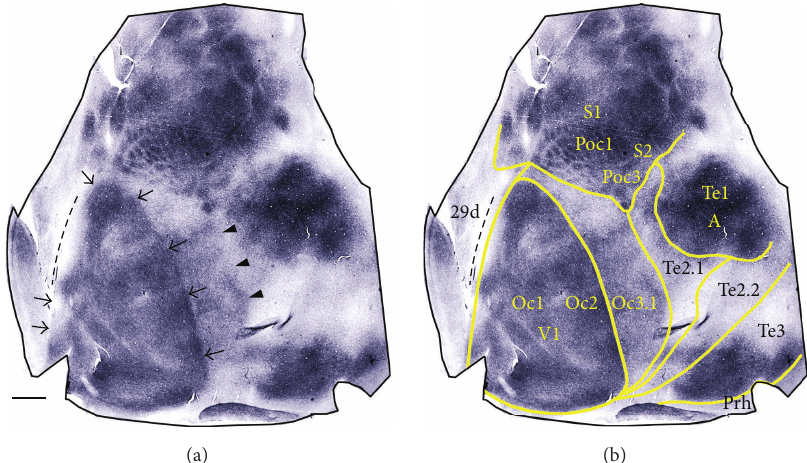
Figure 2: Myeloarchitectonic and cytoarchitectonic borders. Case albino 86-20. (a) Cortical myeloarchitecture. Arrows and arrowheads indicate areas of dense myelination. (b) Relation of myelination pattern to cytoarchitectonic map [44]. Segmented line indicates the lateral sulcus. Medial is to the left and posterior is down. Oc: area occipitalis, Te: area temporalis, Prh: area perirhinalis, Poc: area postcentralis,